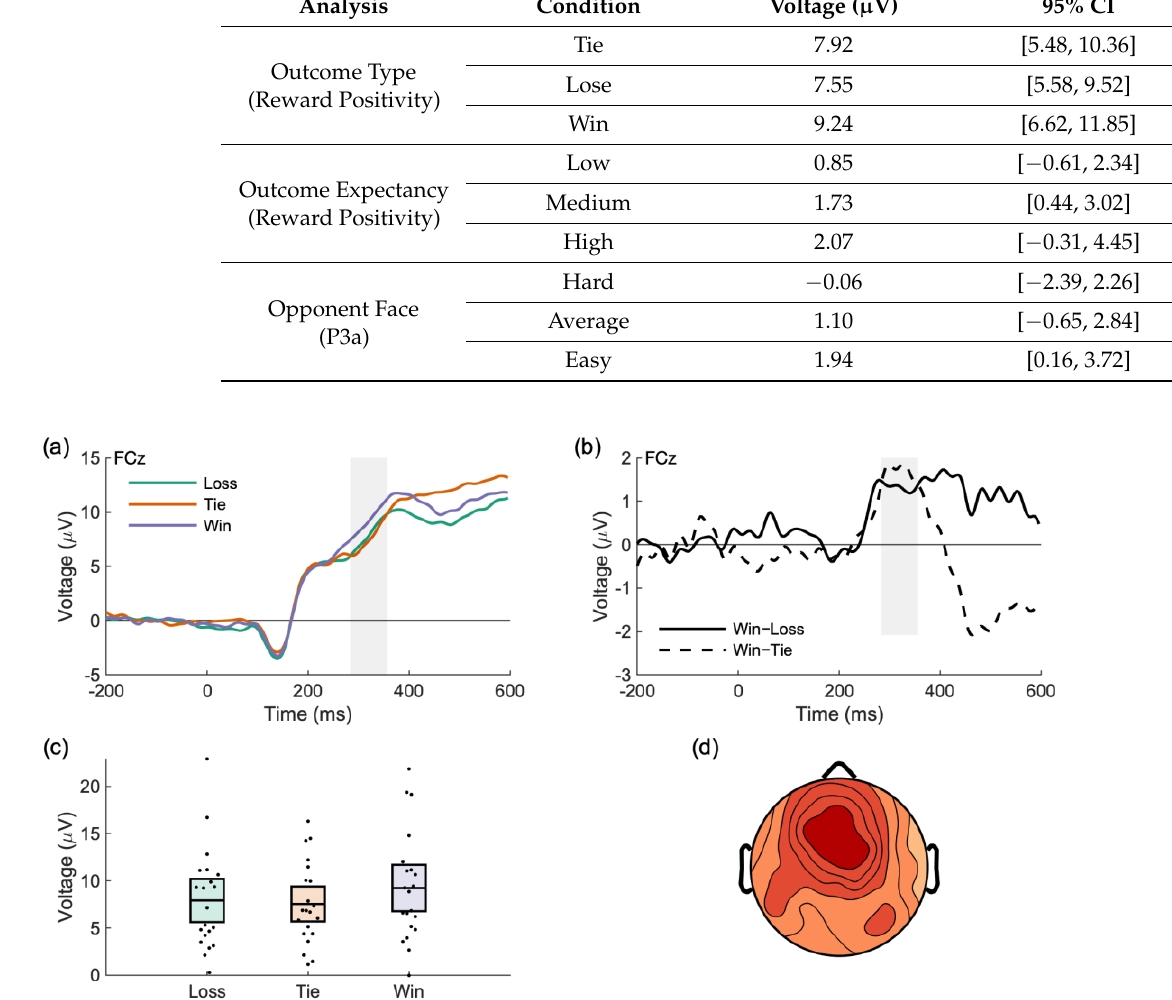
Figure 4. Neural response to feedback differentiated wins from losses and ties. ( a ) A positive deflection for wins was observed relative to ties/losses. The shaded area shows the region of analysis. ( b ) The difference waves show the effect to be in a time range and scalp location consistent with the reward positivity component. ( c ) Reward positivity scores for each outcome type. Error bars indicate 95% confidence intervals. ( d ) The reward positivity was located at a frontal-central scalp location.